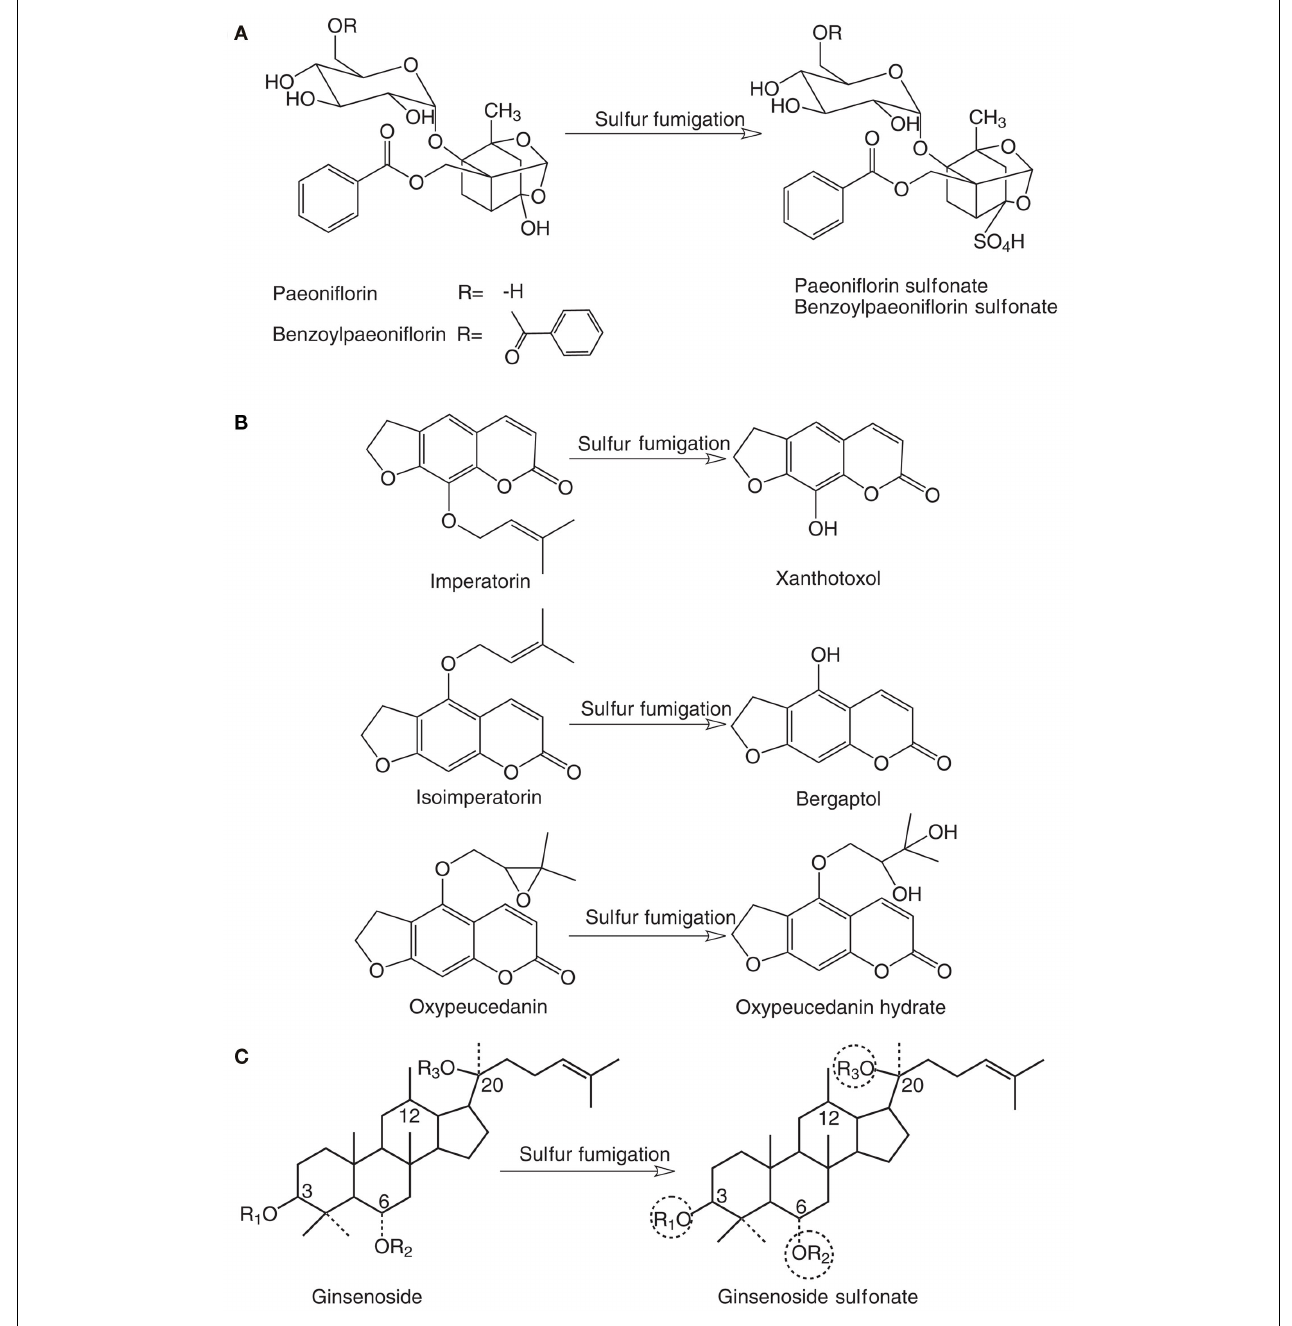
FIGURE 1 | Chemical alterations after sulfur fumigation in (A) Paeoniae RadixAlba (Bai Shao); (B)Angelicae Dahuricae Radix (Bai Zhi); and (C) Ginseng Radix et Rhizoma (Ren Shen). R1, R2, and R3 represent different sugar moieties, and one of these circled sugar moieties were replaced with SO 3 H group after sulfur